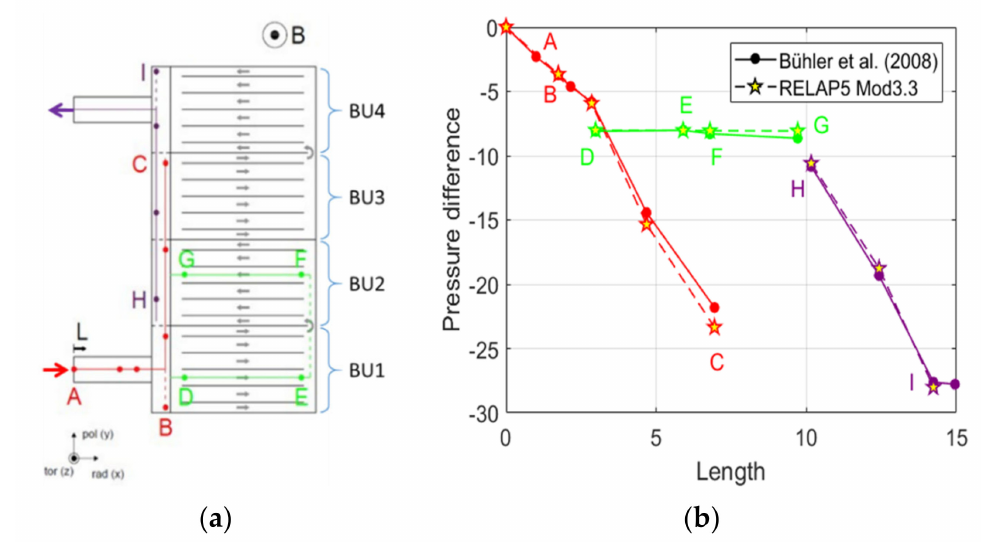
Figure 3. ( a ) Poloidal–radial sketch of the TBM geometry. The flow path (A–I) is depicted with colored lines; ( b ) Numerical results (stars) and experimental data (dots) for nondimensional pressure drop vs. normalized length of the flow path ( Ha = 3000, Re =